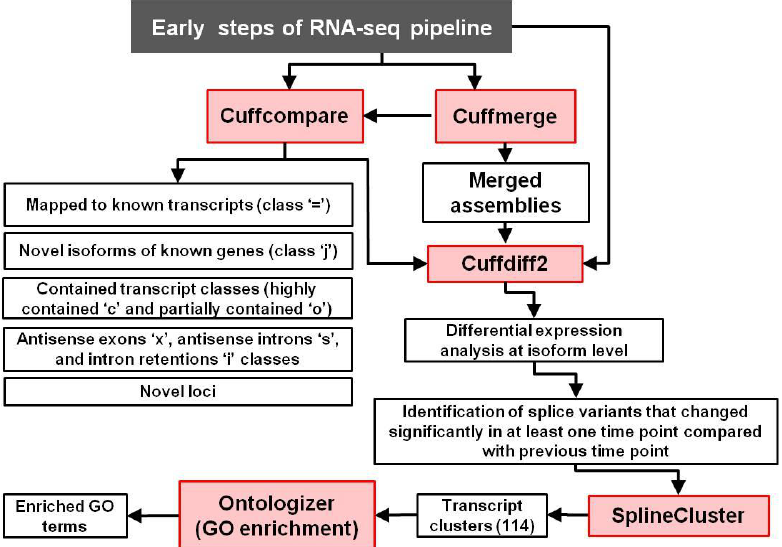
Figure 1. Flowchart of bioinformatics analyses used for differential expression of splice isoforms and subsequent data mining. The initial steps of the RNA-seq pipeline are described in [53] and tools are in red